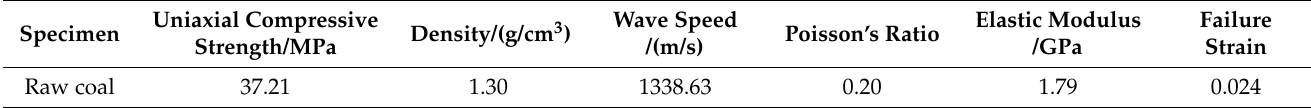
Table 1. Physical parameters and mechanical properties of coal specimens.